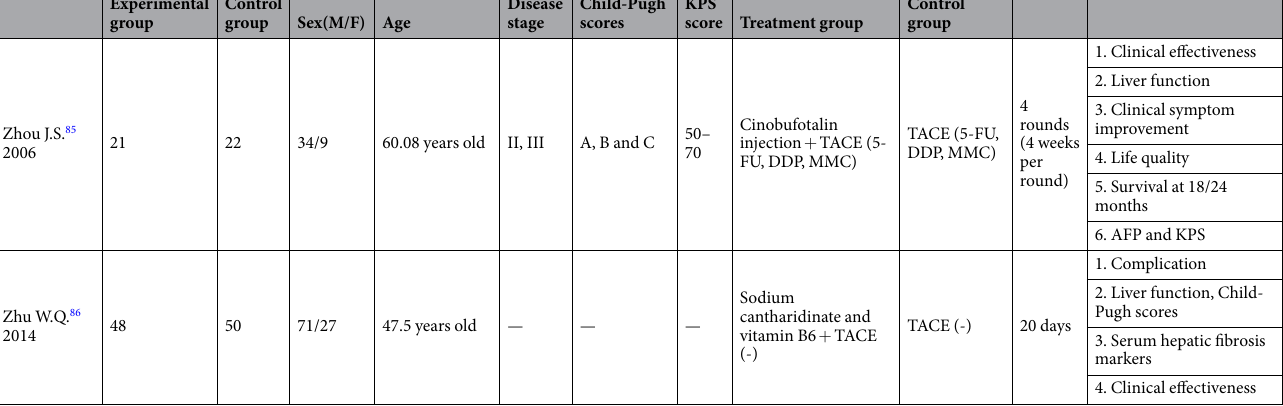
Table 1. General Characteristics of Included Randomized Clinical Trials Note: E: Experimental group; C: Control group; M: Male; F: Female; KPS: Karnofsky performance score; RCT: Randomized clinical trial; TACE: Transcatheter hepatic arterial chemoembolization; THM: Traditional herb medicine; AFP: Alpha- fetoprotein; Th1: Helper T cell type 1; Th2: Helper T cell type 2; HIF-1 α : Hypoxia inducible factor-1 α ; MST: Median survival time; TTP: Time to progression; QoL: Quality of life; VEGF: Vascular endothelial growth factor; WBC: White blood cell; TBIL: Total bilirubin; ALT: Alanine aminotrnsferase; ALB: Albumin; MTTP: Median time to progression; CBR: Clinical beneficial rate; IFN: Interferon; OXA: Oxaliplatin; EPI: Epirubicin; 5-FU: 5-fluorouracil; THP: Pirarubicin; DDP: Cisplatin; CF: Calcium folinate; GEM: Gemcitabine;